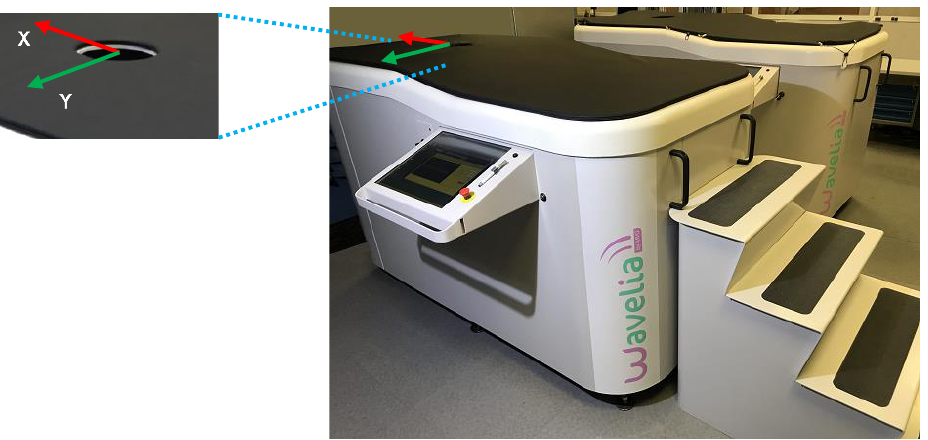
Figure 1. The Wavelia prototype medical device: the OBCD subsystem (on the Front) and the MBI subsystem (on the Rear). The Wavelia reference coordinate system is also shown (red and green axes).